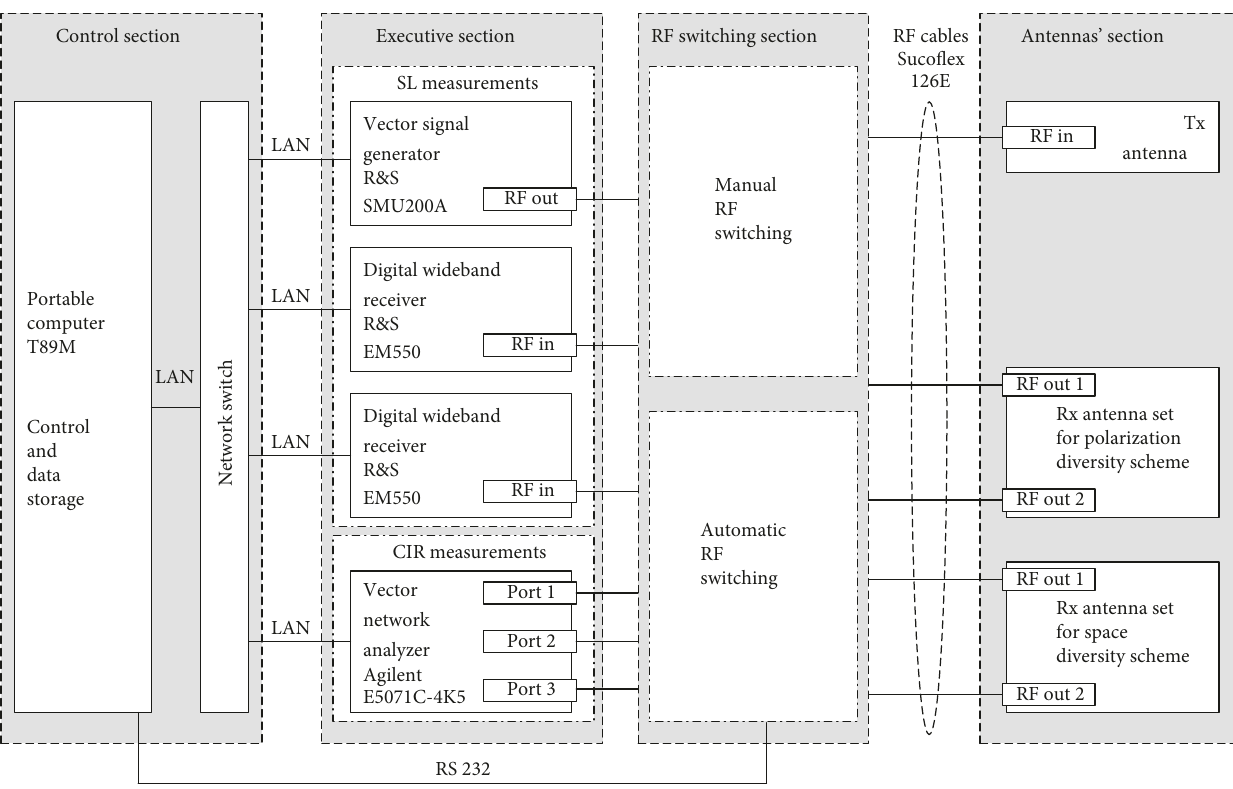
Figure 1: The block diagram of the versatile measurement stand for radio channel measurements in WBANs with space and polarization diversity